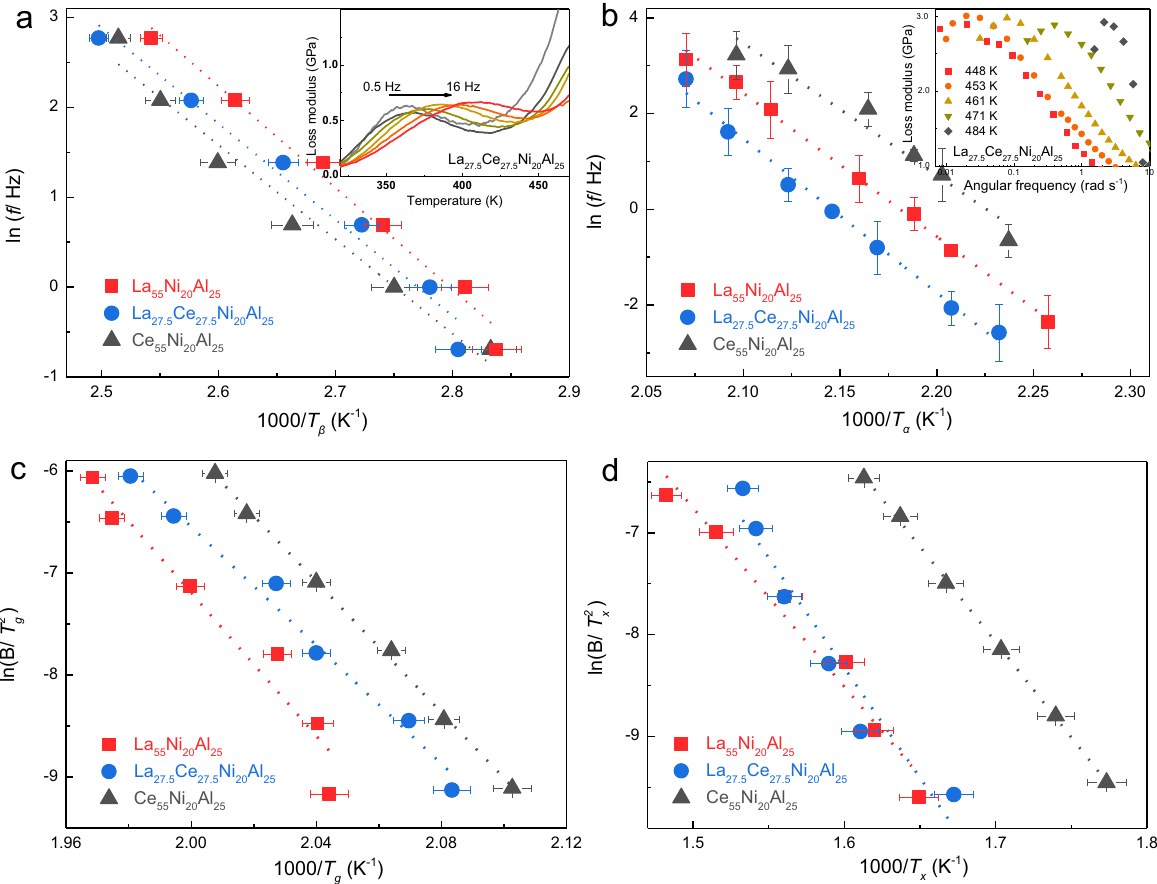
Fig. 5 The activation energies for β -relaxation, α -relaxation, glass transition, and crystallization of the La(Ce)NiAl system. a Arrhenius plots of the temperature and frequency dependence of the peak temperature of β - relaxations for the La(Ce)NiAl system. The inset shows the temperature-dependent loss modulus of LaCe-HEMG with testing frequencies ranging from 0.5 to 16 Hz. b Frequency and temperature dependence of the peak temperature of α - relaxations fi tted with the Arrhenius relationship. The inset presents the frequency-dependent loss modulus of LaCe-HEMG at different temperatures. c , d Kissinger plots of thermal T g and T x versus heating rate for the La(Ce)NiAl system, respectively. The error bars were obtained by standard deviation from three measurements of T β , T α , and T g , T x on DMA and DSC curves,